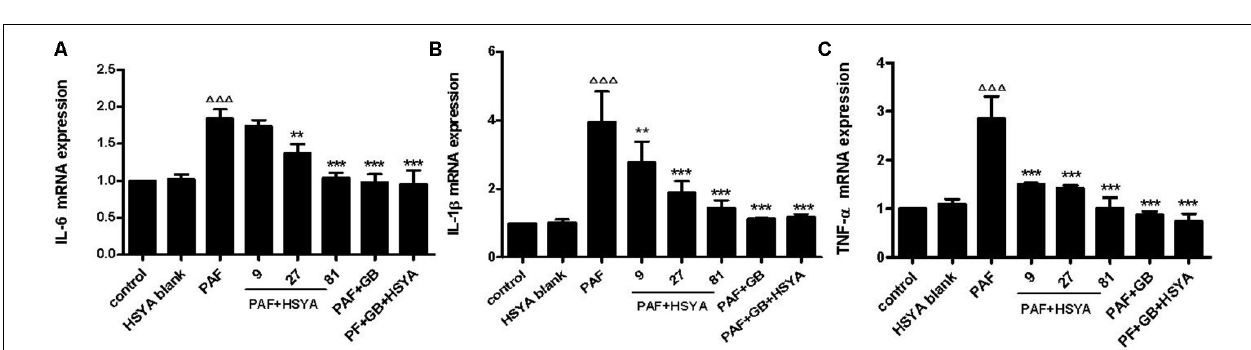
FIGURE 3 | Effects of HSYA on IL-6 (A) , IL-1 β (B) , and TNF- α (C) mRNA expression levels in PAF-stimulated HSAECs determined by RT-PCR. Data presented as mean ± SD, n = 3 per group. ANOVA, p < 0.0001 (A) , p < 0.001 (B) , p < 0.0001 (C) . post hoc (cid:49)(cid:49)(cid:49) p < 0.001 versus control group, ∗ p < 0.05, ∗∗ p < 0.01, ∗∗∗ p < 0.001 versus PAF